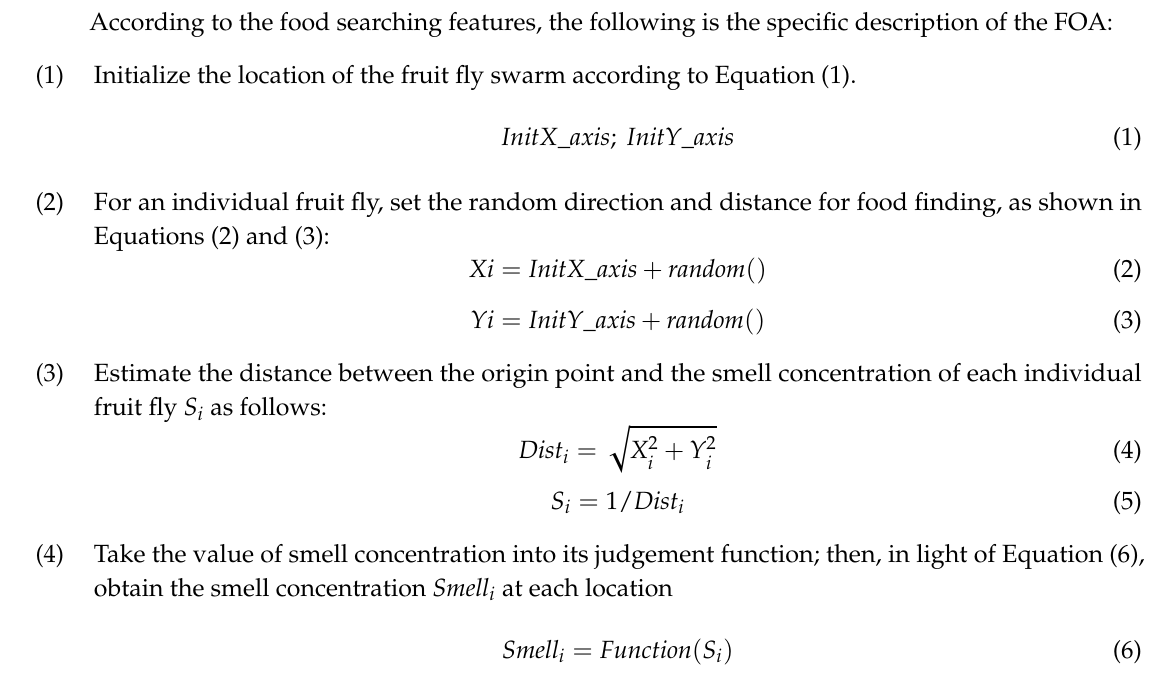
Figure 1. Food searching procedure of a fruit fly swarm.